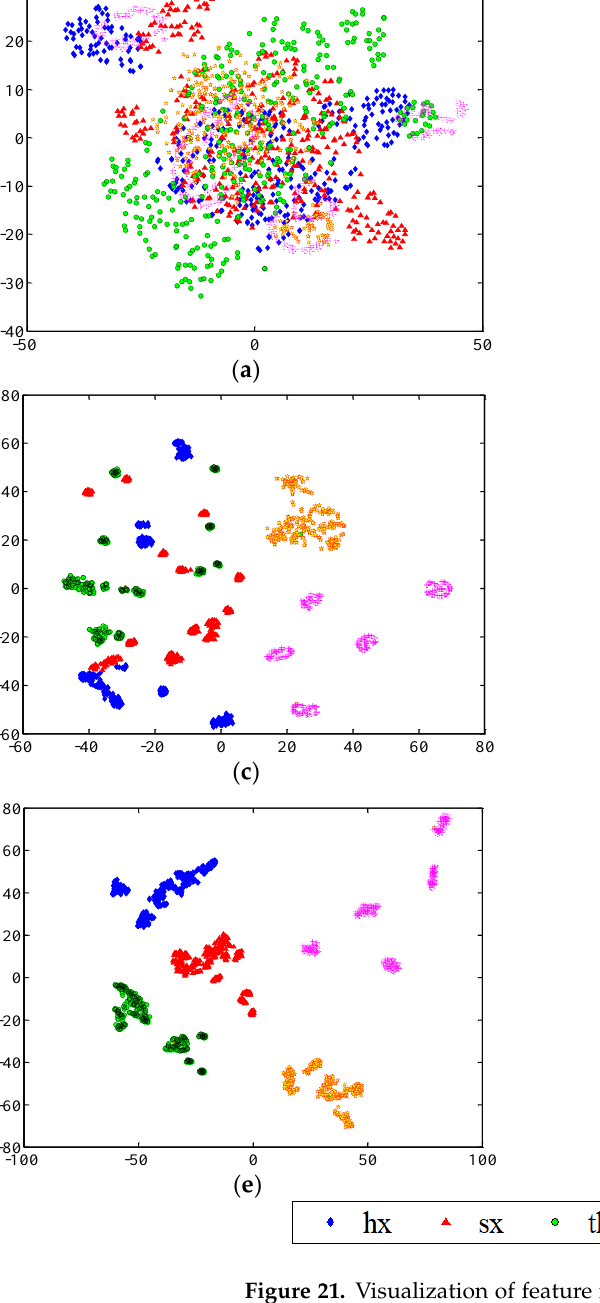
Figure 21. Visualization of feature representation via t -SNE. ( a ) Input data, ( b ) C1, ( c ) C3, ( d ) C5, ( e ) FC2, ( f ) classifier layer .